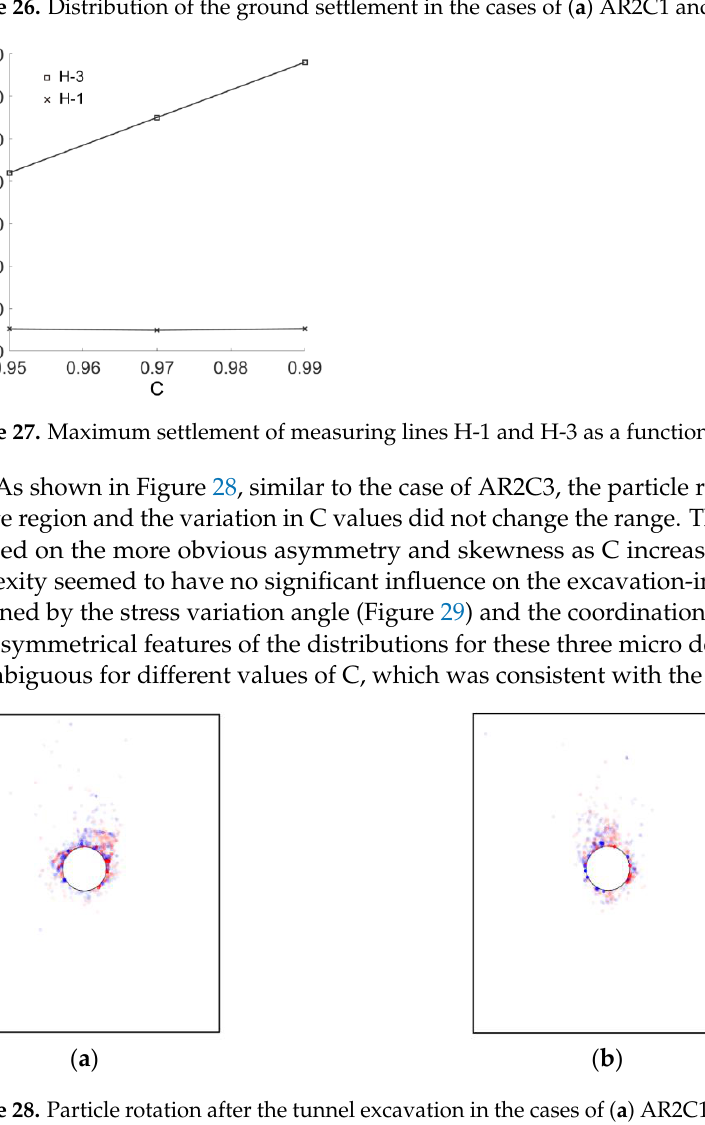
Figure 26. Distribution of the ground settlement in the cases of ( a ) AR2C1 and ( b ) AR2C2.